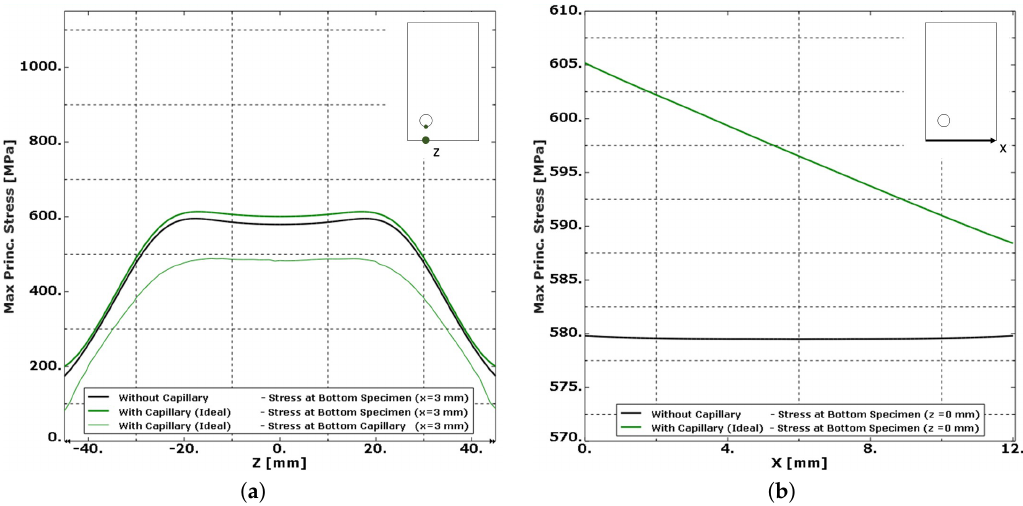
Figure 12. The maximum principal stress level plotted in function of ( a ) the longitudinal Z-direction at the bottom of the specimen and bottom of the capillary and ( b ) the X-direction at the bottom of specimen. The integration of a capillary slightly increases (+3%) the overall stress level in the specimen. The stress level at the capillary is significantly lower than that at the bottom of the specimen. The stress level increases linearly by 3% from the corner without capillary to the corner with